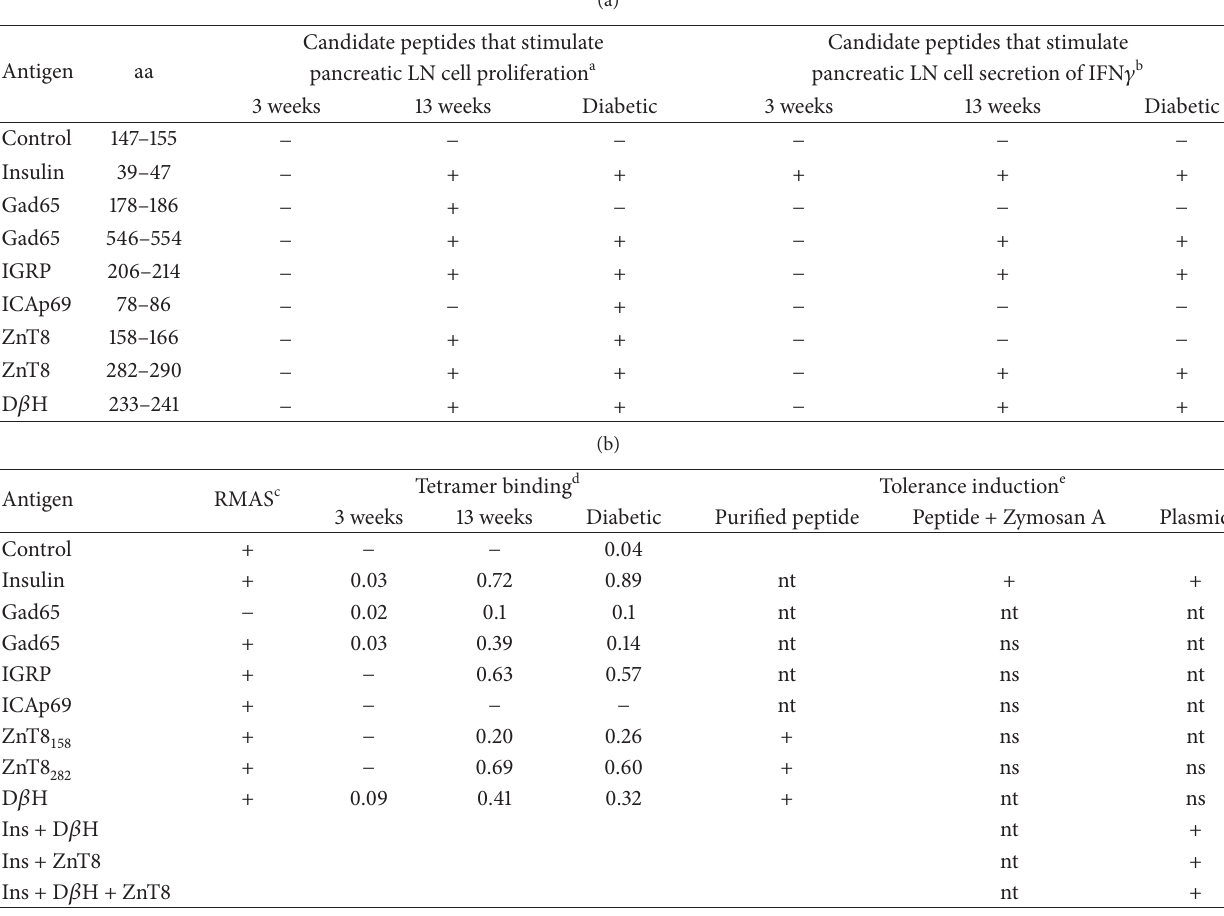
Table 2: Summary of peptide epitope data. Cells were obtained from mice at ages as indicated and were assayed as described in “Section 2.” For stimulation of proliferation the data was internally controlled for each experiment and scored as “fold stimulation” (over background using control peptide) as determined as described in Section 2. Examples of each type of data are shown in the paper figures.